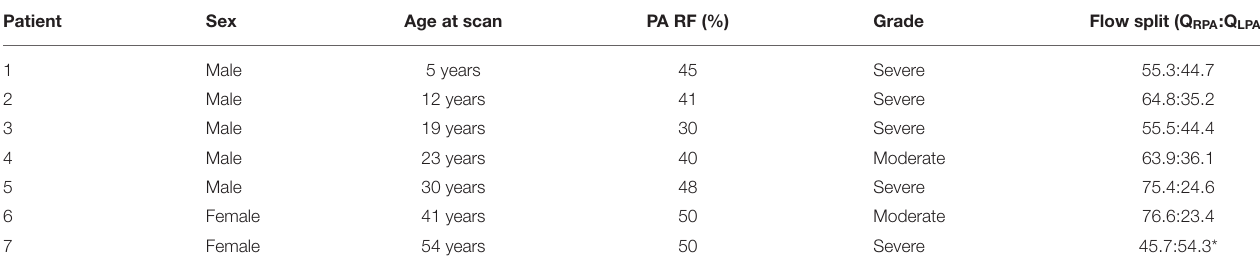
TABLE 1 | Demographic and hemodynamic data of the repaired TOF cases.